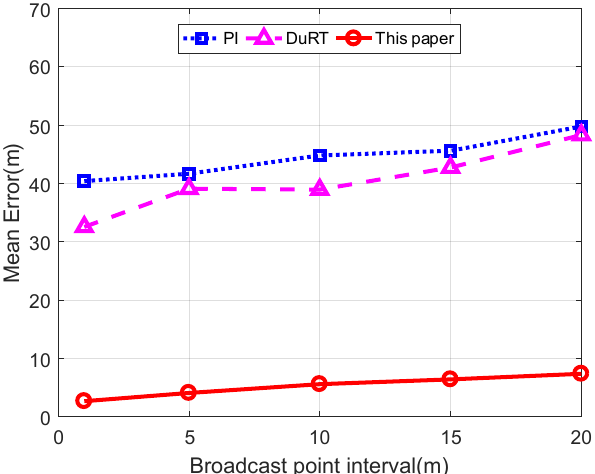
Figure 16. Comparison of the mean location error of the three